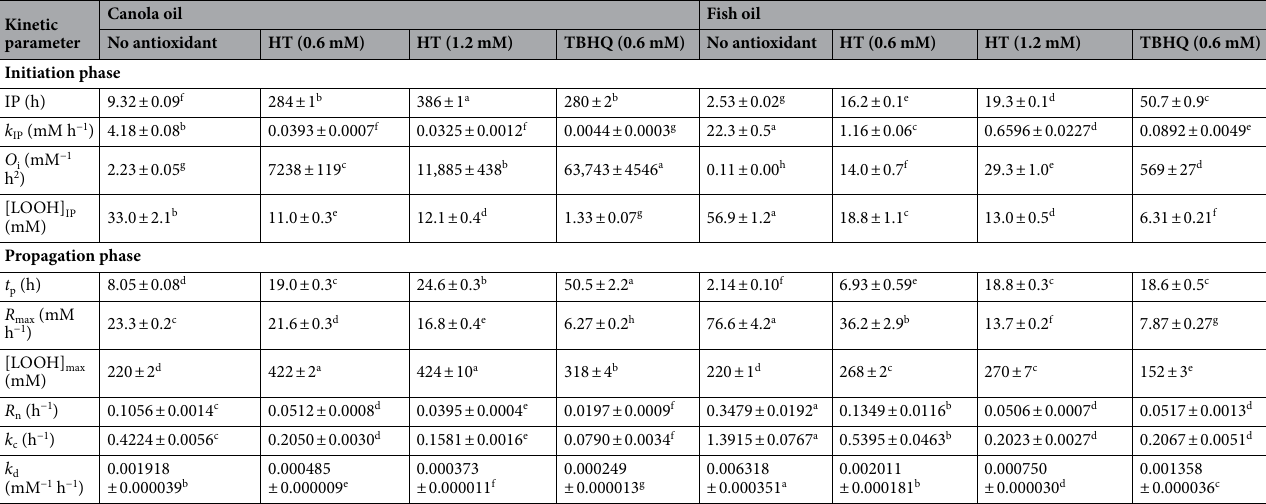
Table 2. The kinetic data resulting from the linear and sigmoidal functions fitted on the kinetic curves of the accumulation of lipid hydroperoxides (LOOH) during the non-inhibited and inhibited (hydroxytyrosol, HT, and tert -butylhydroquinone, TBHQ) peroxidations of the oil samples at 60 °C. Means ± SD (standard deviation) within a row with the same lowercase letters are not significantly different at P < 0.05. IP Induction period, k IP the pseudo-zero order rate constant of initiation phase, O i initiation oxidizability parameter, [LOOH] IP LOOH concentration at IP, called as critical reverse micelle concentration (CMC) of lipid hydroperoxides (CMC L ), t P duration of the propagation phase, R max the maximum rate of LOOH accumulation, [LOOH] max the maximum concentration of LOOH, R n propagation oxidizability parameter, k c a composite (pseudo-first order) rate constant, k d the decomposition (pseudo-second order) rate constant of the bimolecular reaction of preformed LOOH.